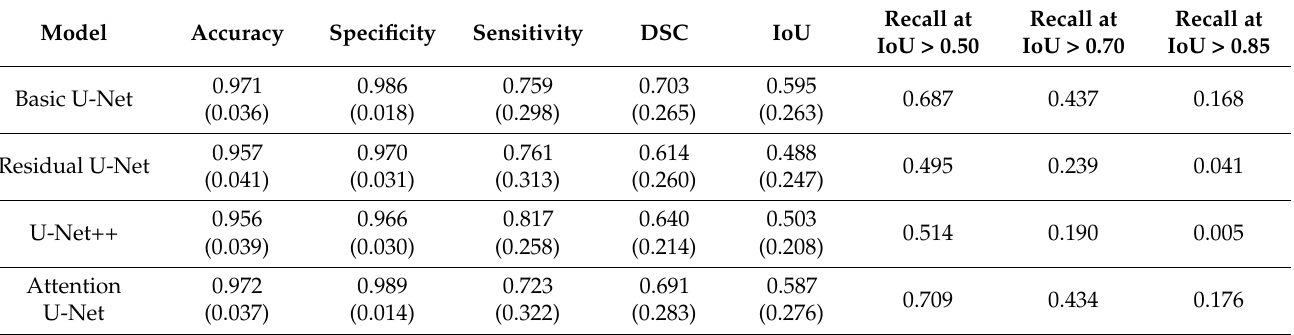
score greater than the threshold is